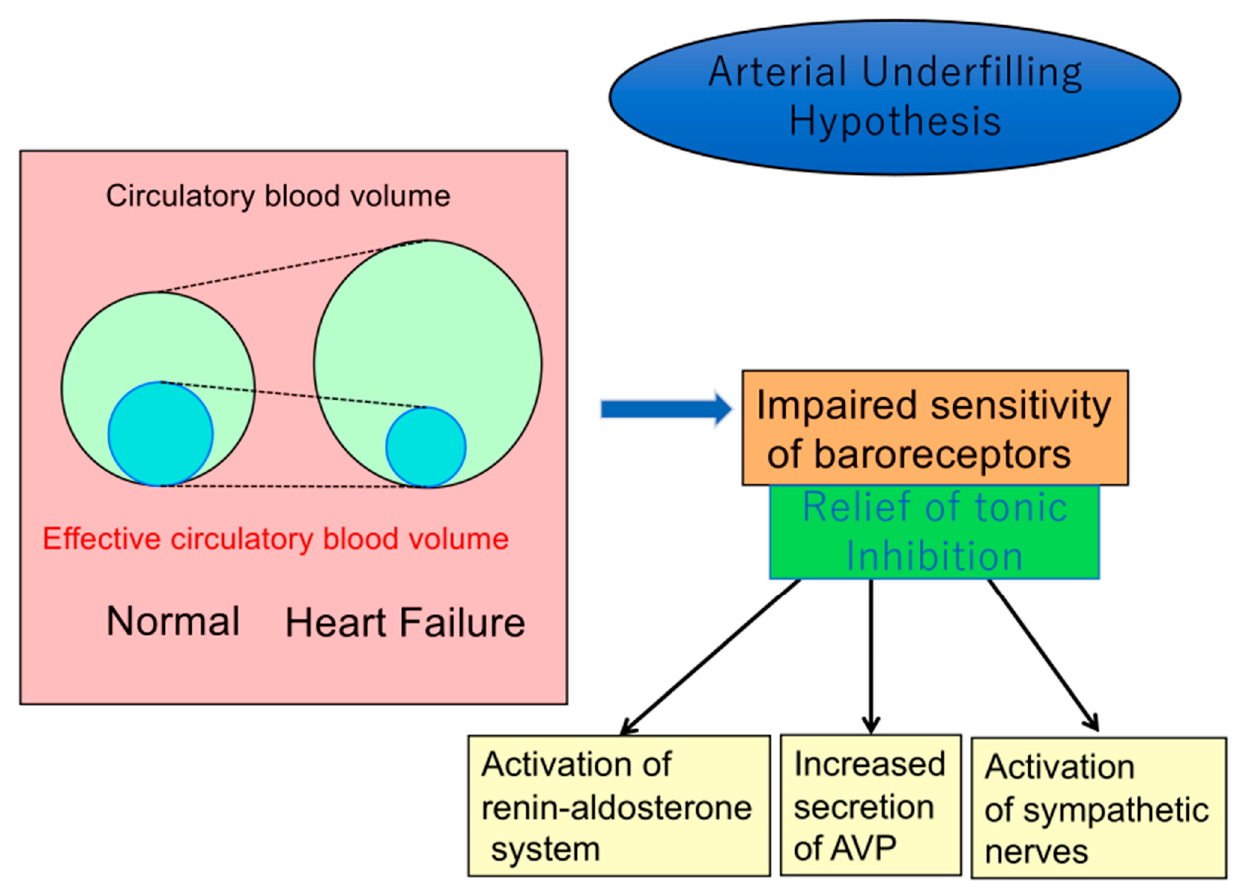
Figure 1. Arterial underfilling hypothesis for dysregulation of baroreceptor-mediated hormonal release in congestive heart failure.